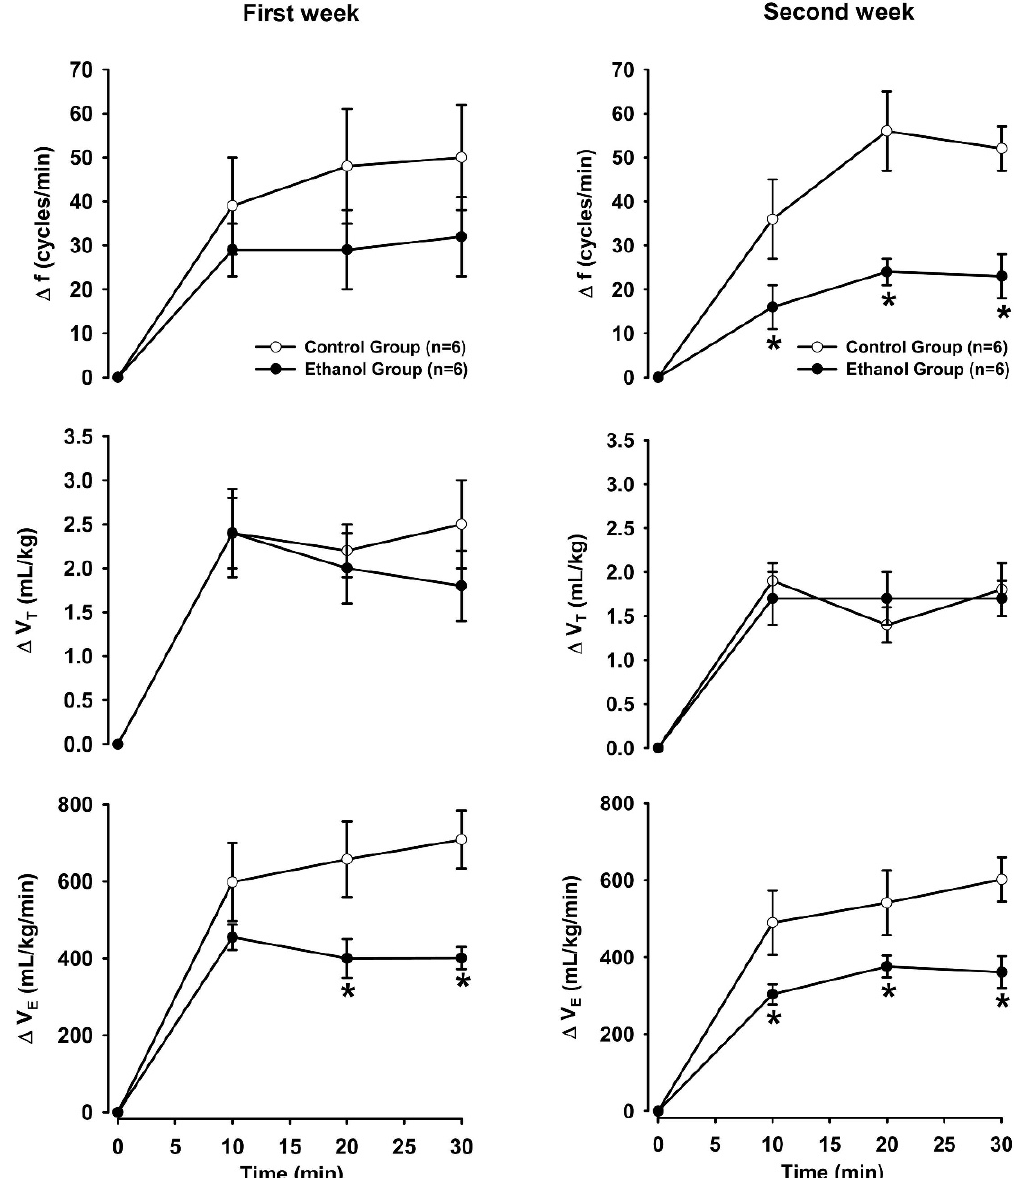
Figure 2 - Changes during the first (left panel) and second (right panel) weeks in respiratory frequency (f, top), tidal volume (V T , middle) and minute ventilation (V E , bottom) in response to 10% O 2 -mediated hypoxia in rats receiving water (control group) or ethanol (ETOH) in increasing concentrations (first week: 5% v/v, second week: 10% v/v, third and fourth weeks: 20% v/v). Values are expressed as the mean ¡ SEM. *, p , 0.05 (two-way ANOVA) compared to control